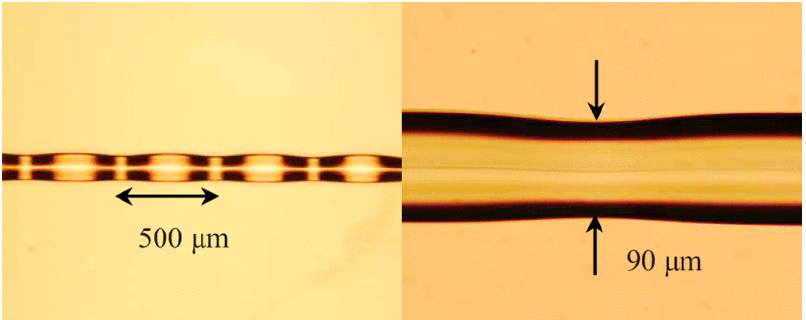
Figure 12. Microscope image of the fabricated SPTS [39]. Reproduced with permission from Pengfei